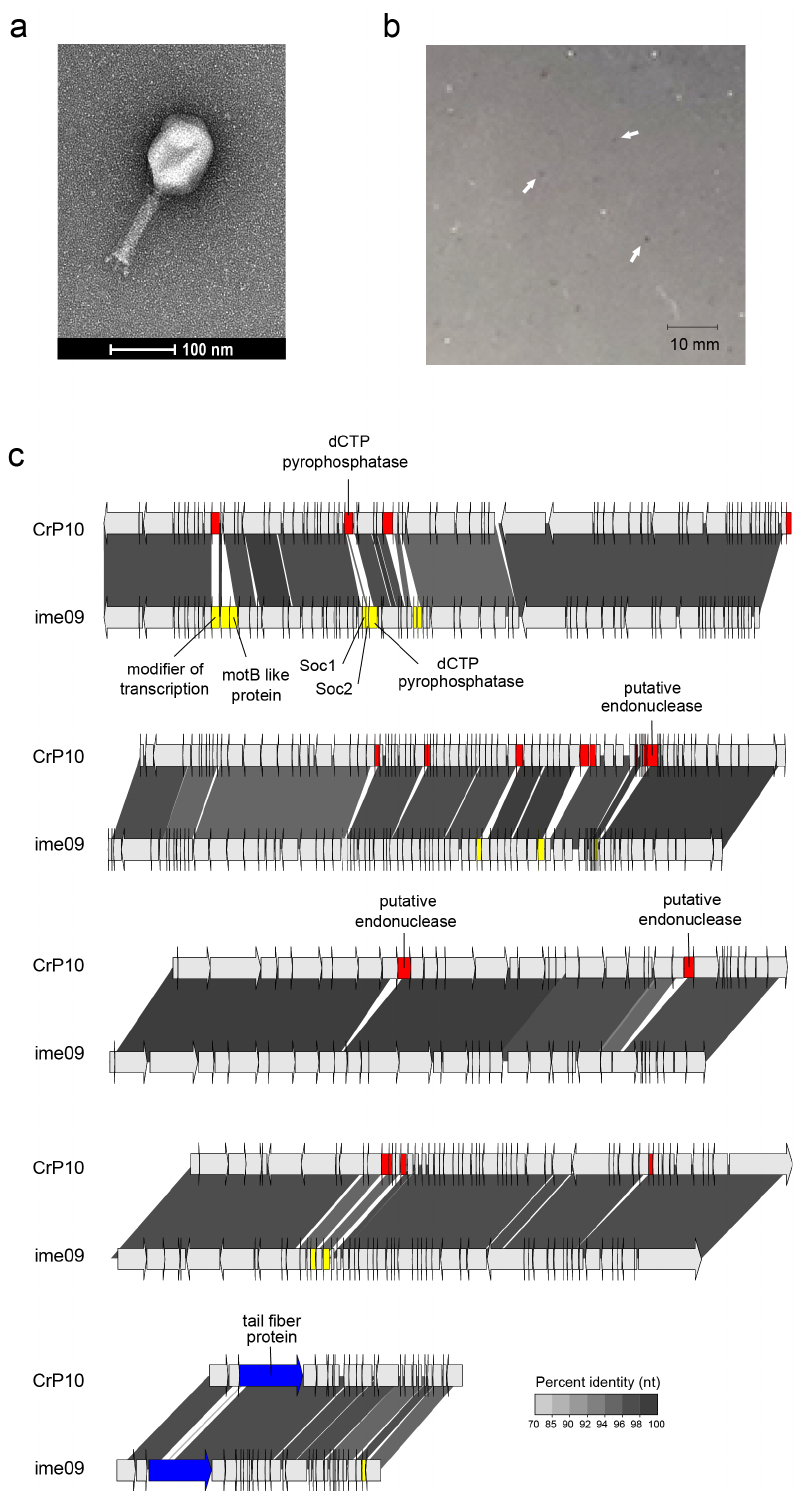
Figure 2. Morphology, genome organization and gene functional comparison of CrRp10. ( a ) Electron micrographs of CrRp10 negatively stained with uranyl acetate. ( b ) Plaque forming units (highlighted by arrows) on lawns of C. rodentium ICC180 after 24 h or growth. ( c ) Genome alignment of CrRp10 and its closest taxonomic relative E. coli phage ime09. Genes are colored according to nucleotide sequence homology, with genes exclusive to CrRp10 labeled red, genes exclusive to ime09 labeled yellow, and homologous genes with < 70% identity labeled